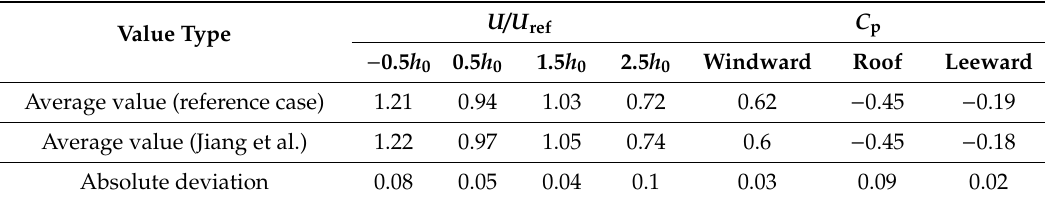
Figure8. Comparisonofnormalizedvelocity U / U ref distributionaroundthebuildingonthemeasurement Figure 8. Comparison of normalized velocity U/U ref distribution around the building on the line: ( a ) 2.5 h 0 , ( b ) 1.5 h 0 , ( c ) 0.5 h 0 and ( d ) − 0.5 h 0 . measurement line: ( a ) 2.5 h 0 , ( b ) 1.5 h 0 , ( c ) 0.5 h 0 and ( d ) − 0.5 h 0 . Table 1. Comparison of average value of normalized velocity U / U ref and wind pressure coe ffi cient C p on measurement